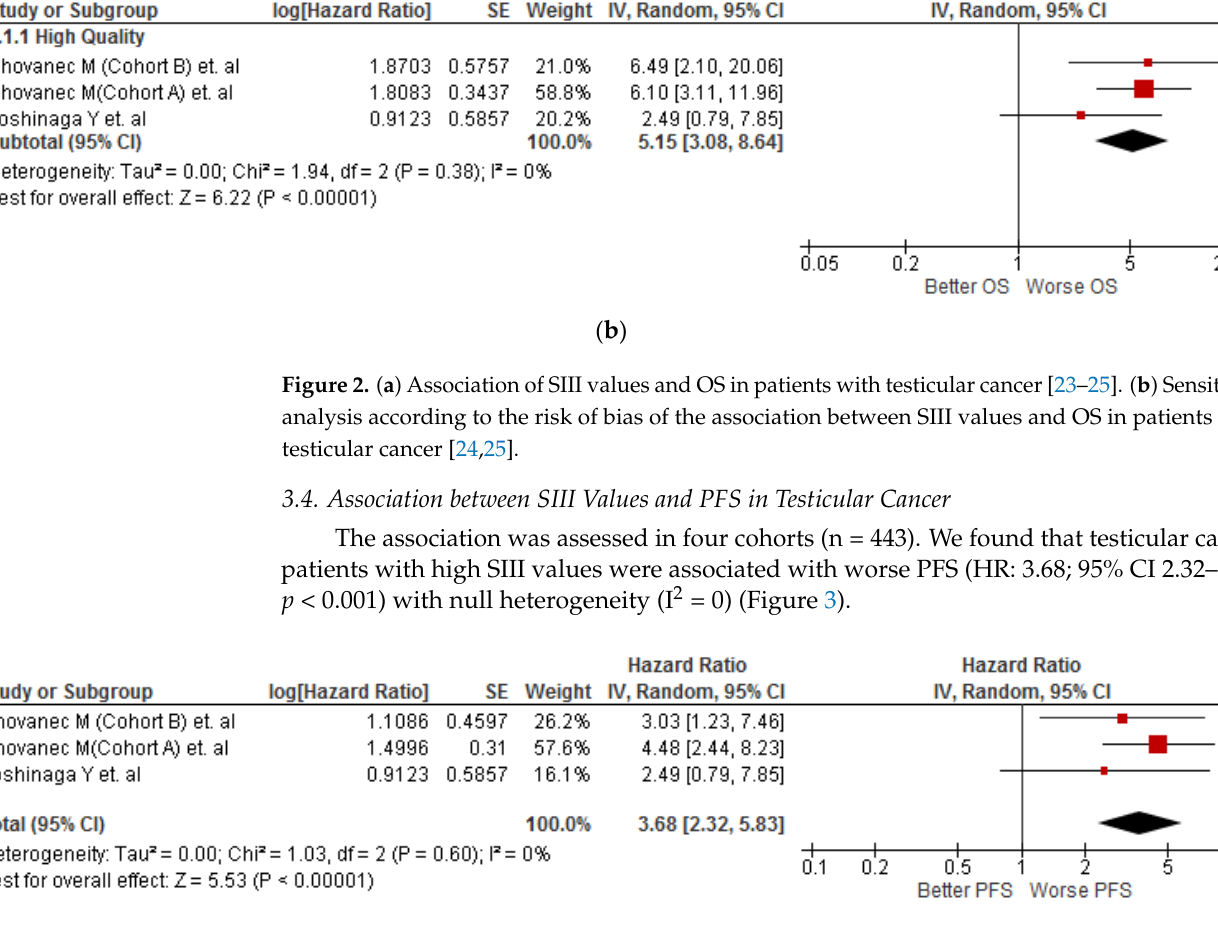
Figure 3. Association of SIII values and PFS in patients with testicular cancer [24,25].